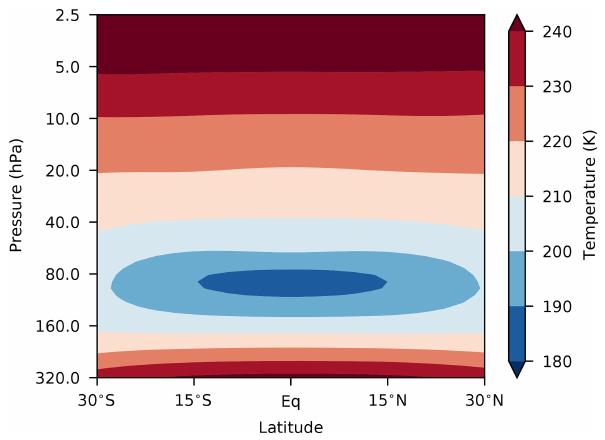
Figure 4. Latitude–height cross section of the zonal mean tempera- ture T in